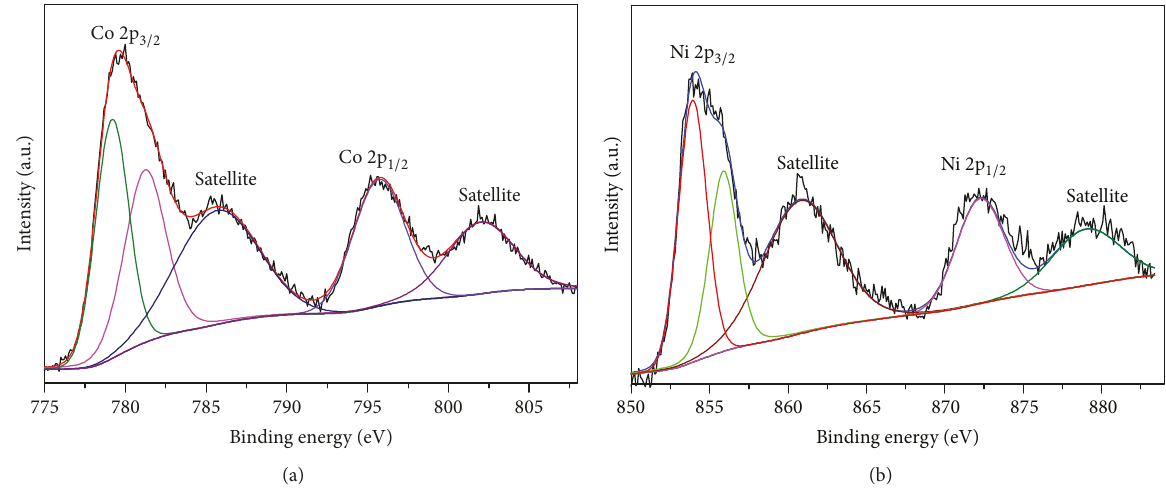
Figure 6: XPS spectra for (a) cobalt 2p and (b) nickel 2p. The colored solid lines below the spectra are derived from curve-fitting analysis.